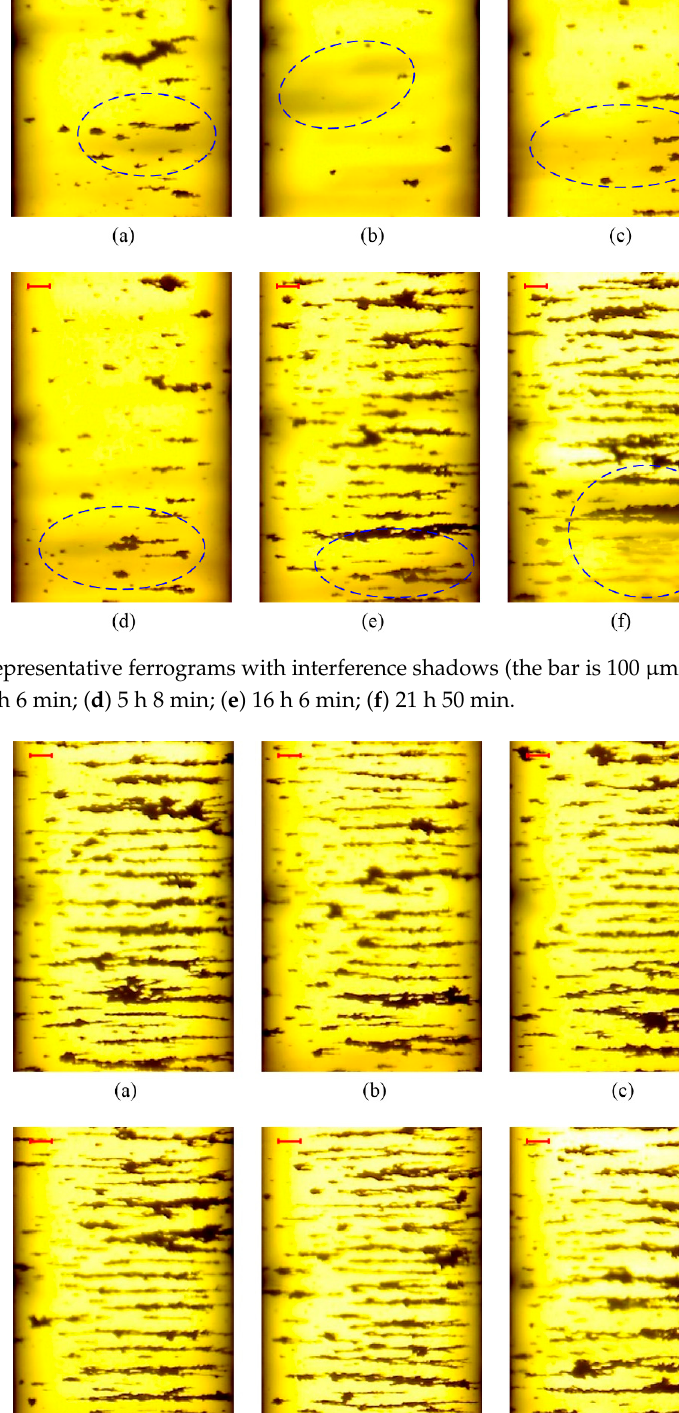
Figure 11. Representative ferrograms without interference shadows (the bar is 100 µ m): ( a ) 25 h; ( b ) 30 h; ( c ) 35 h; ( d ) 40 h; ( e ) 45 h; ( f ) 50 h.